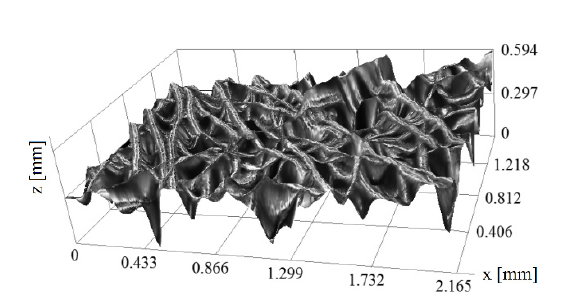
Figure 2. Microgeometry profile of the metal – fibrous coating measured with a 3D digital microscope